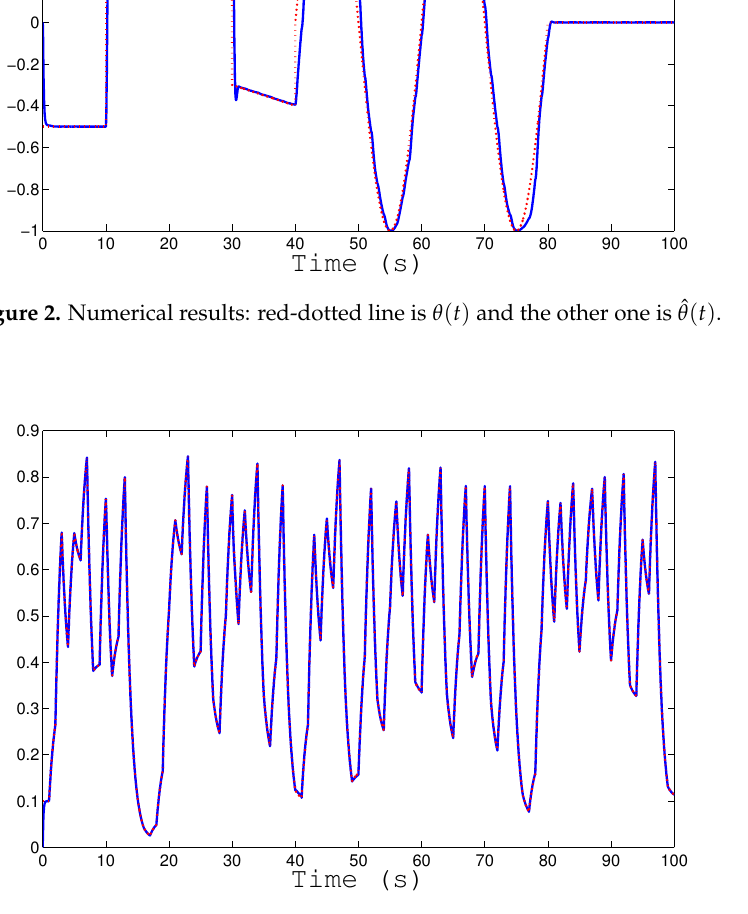
Figure 3. Numerical results: red-dotted line is x r ( t ) and the other one is x i ( t ) .